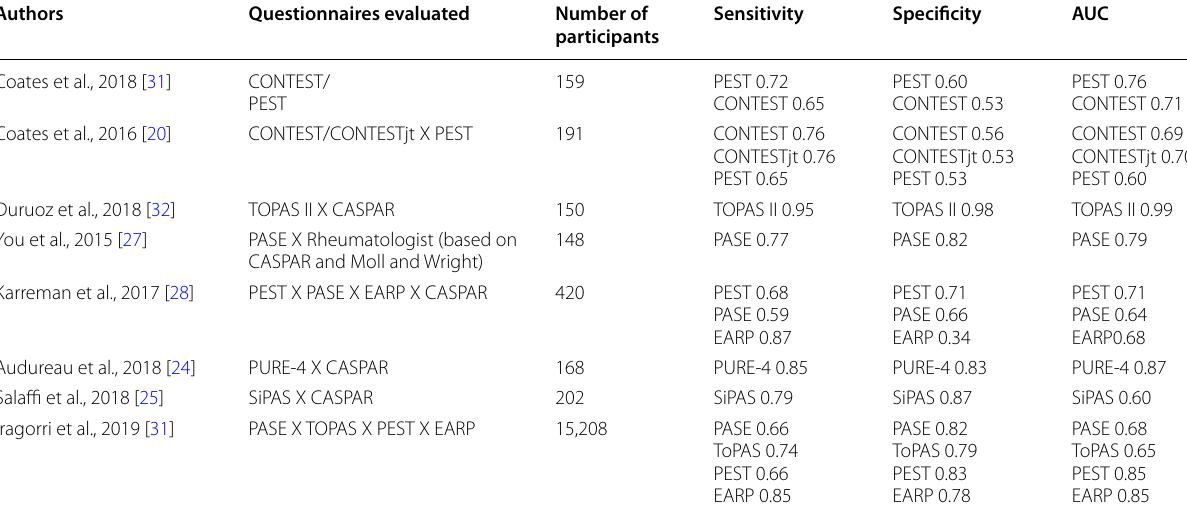
CASPAR Classification Criteria for Psoriatic Arthritis; CONTEST = CONTESTjt CONTEST with the addition of a joint manikin; EARP = PAQ Psoriasis and Arthritis Questionnaire; PASQ = arthritis UnclutteRed screening Evaluation; SiPAS